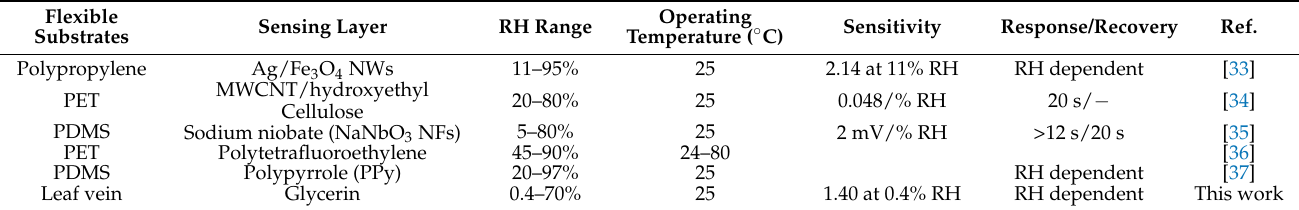
Table 2. Summary of recently reported flexible humidity